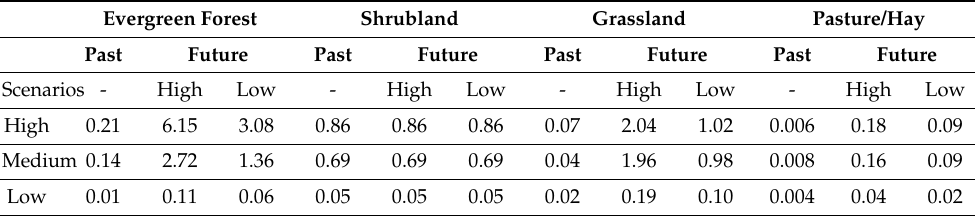
Table 3. Suitability classes under four land covers with their respective historical and future rate of change on an annual basis.